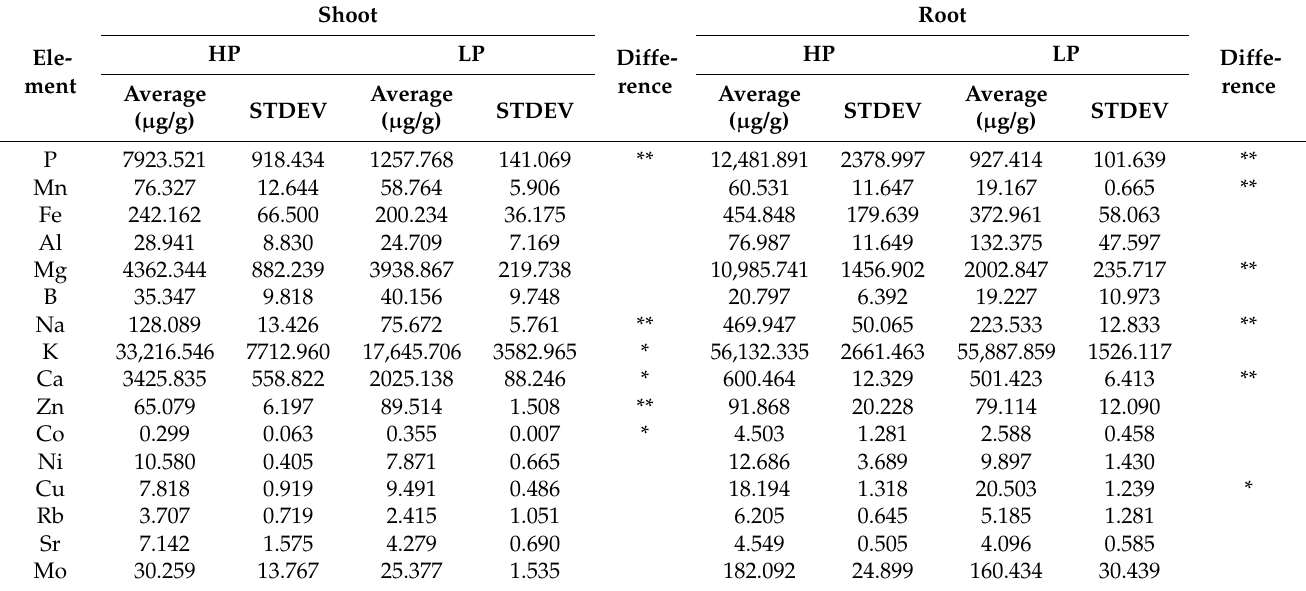
Table 1. Concentration of nutrient elements measured by